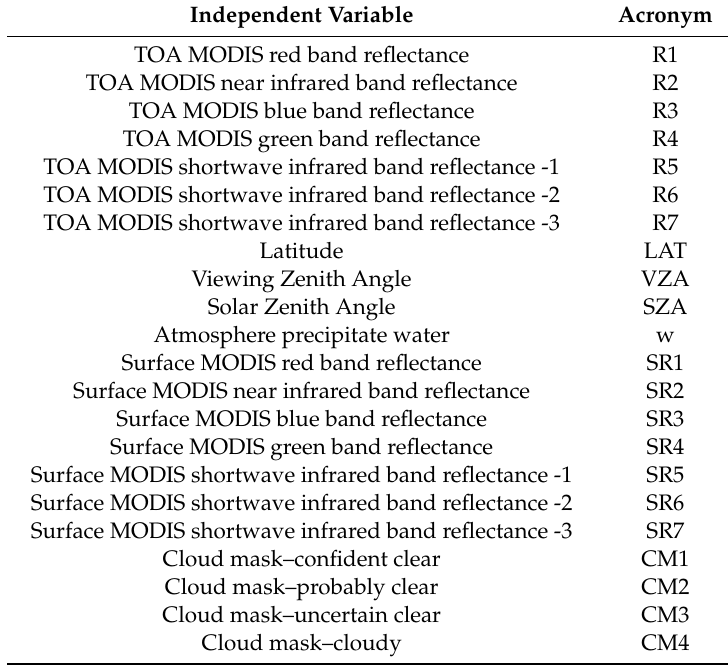
Figure 2. Flowchart of net surface shortwave radiation retrieval methodology. Table 2. Selected independent variables for the net surface shortwave radiation (NSSR) model and their acronyms.